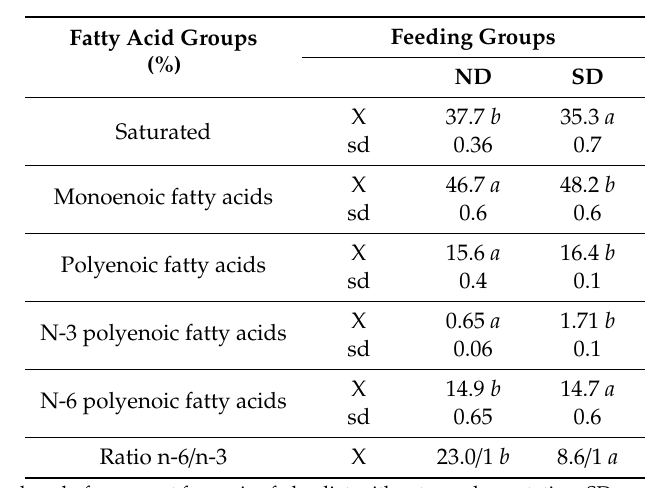
Figure 1. Sensory profile of cured hams. ND—cured ham produced of raw meat from pigs fed a diet without supplementation, SD—cured ham produced of raw meat from pigs fed a diet supplemented with rapeseed oil and mineral additive. Table 4. Fatty acids profile of cured ham (n = 24). ND—cured ham produced of raw meat from pigs fed a diet without supplementation; SD—cured ham produced of raw meat from pigs fed a diet supplemented with rapeseed oil and mineral additive. a , b —di ff erent letters indicate significant di ff erences ( p ≤ 0.05) between